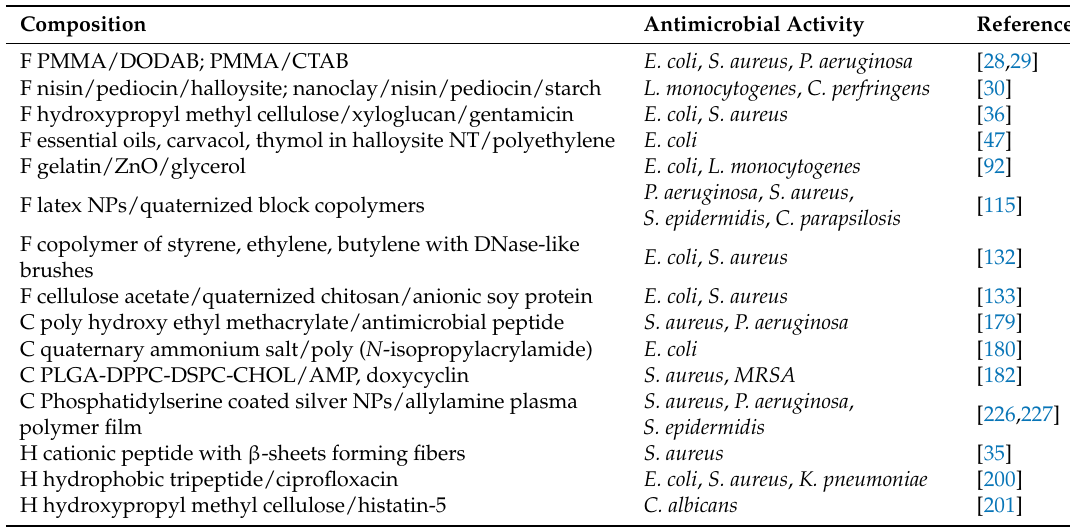
Table 2. Self-assembled films (F), coatings (C), and hydrogels (H): composition and antimicrobial activity.